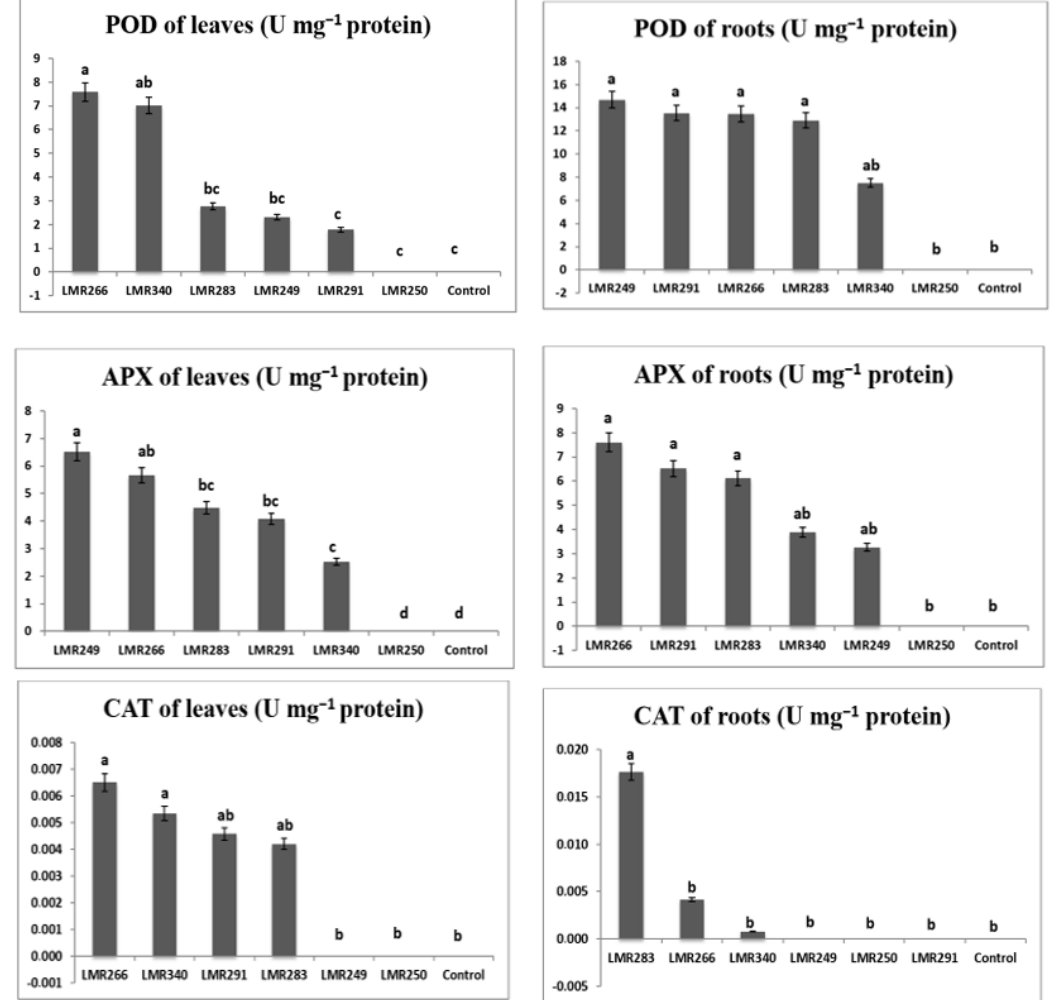
Figure 7. Antioxidant enzymes activities in roots and leaves of Sulla plants 100 days after bacterial inoculation. All the values are means of 4 replicates. One-way ANOVA was performed to determine the influence of inoculated bacteria on antioxidant enzymes for contaminated soil. Means for the different treatments with different letters are significantly different from each other ( p < 0.05) according to the Duncan